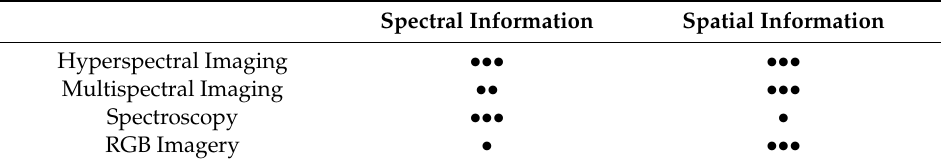
Table 1. Di ff erences between hyperspectral and multispectral imaging, spectroscopy, and RGB (read green blue) imagery. A classification based on a bullet rate (1–3) was used to quantify both the spectral and spatial information associated to each acquisition technique, in relative